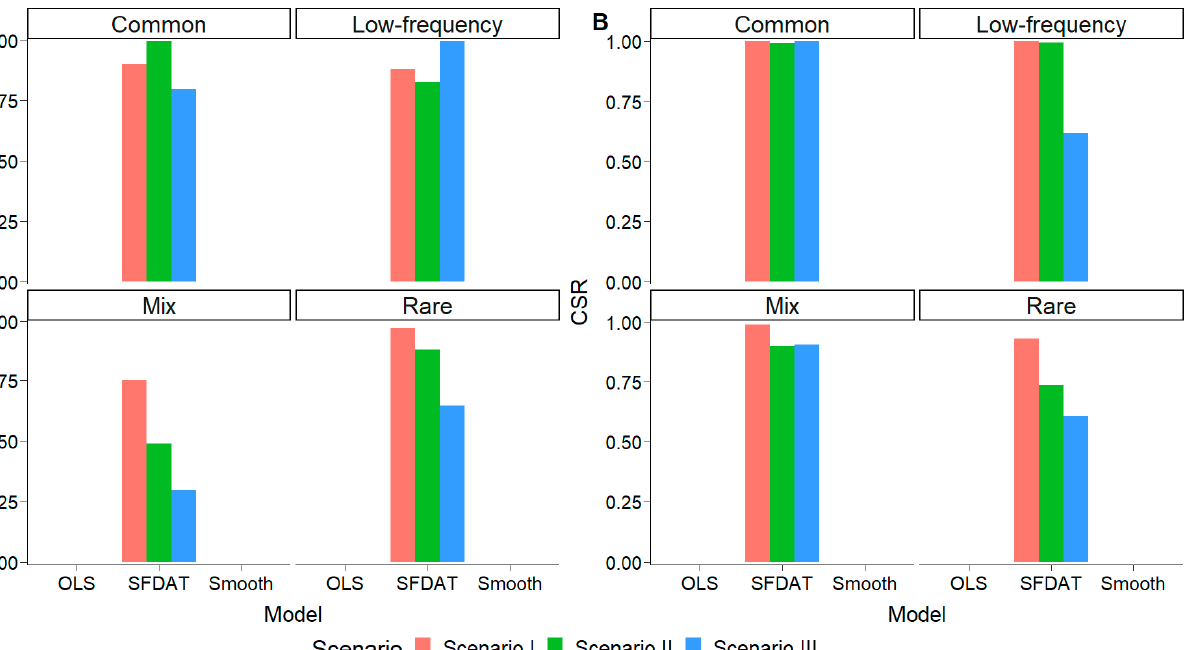
Figure 3. The simulation DL of four variants using OLS, SFDAT and Smooth under three scenarios of Case I. DL 100 , DL 450 , DL 800 denotes the discovery length for non-zero region at locus 100, 450 and 800, respectively. ( A ): The situation of linkage equilibrium; ( B ): the situation of linkage disequilib- rium; Scenario I: Set a positive causal SNP at locus 450 in the gene region. Scenario II: Set a positive causal SNP at locus 100 and 800 in the gene region, respectively. Scenario III: Set a positive causal SNP and a negative causal SNP at locus 100 and 800 in the gene region, respectively. Table 1 illustrates the power of three methods of Case II under the signi fi cant level 0.01. As can be seen from Table 1, under the simulation of linkage equilibrium, the power for common variant regions and low-frequency variant regions are similar, the powers of rare variants regions and mixed variants regions are similar. The powers of the former (common variants and low-frequency variants) are higher than that of the la tt er (rare var- iants and mixed variants), and the powers of rare variant regions are also lower than that of mixed variant regions. That is because the former does not contain rare variants, the